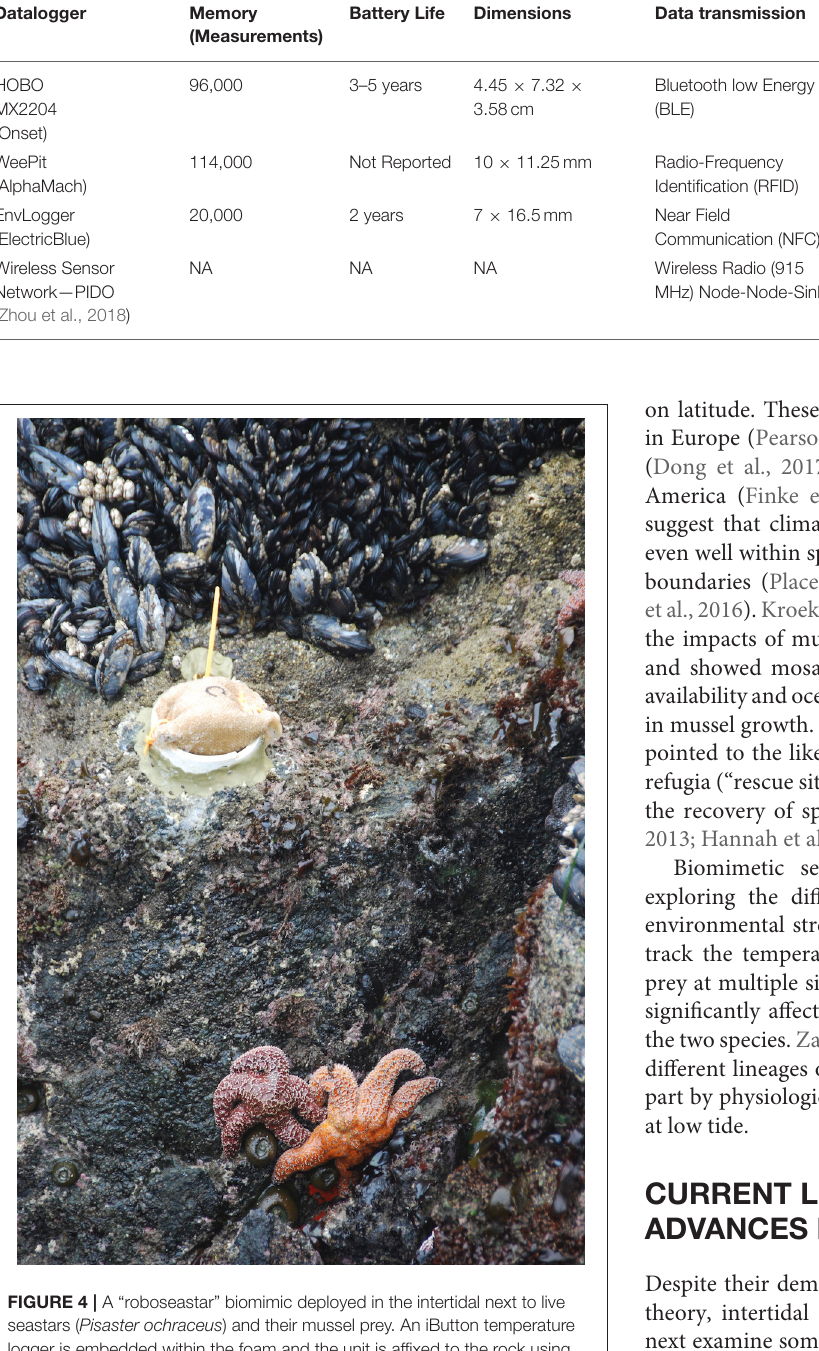
in space and time than previously appreciated. For